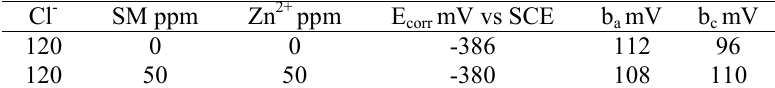
Table 5. Corrosion parameters of carbon steel immersed in various test solution obtained by polarization method,